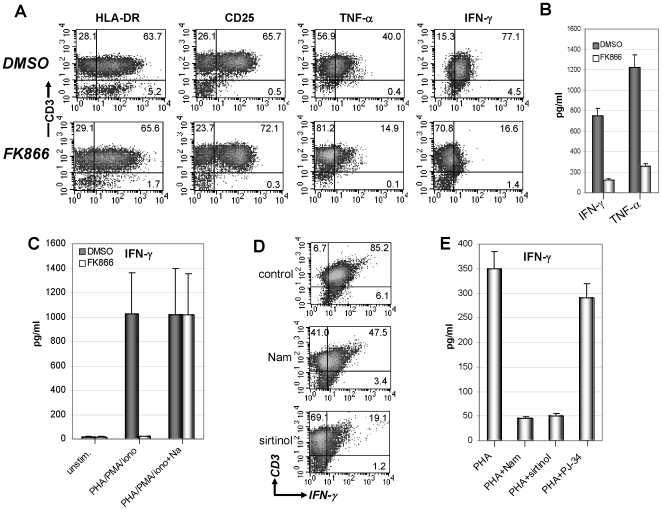
Intracellular NAD+ depletion prevents TNF-α and IFN-γ production by activated T lymphocytes.A, B, 5×106 PBLs were stimulated with 5 µg/ml PHA with or without 33 nM FK866 for 36 h and subsequently incubated with 50 ng/ml PMA and 0.5 µM ionomycin for further 5 h. Thereafter, HLA-DR and CD25 expression were detected by flow cytometry. TNF-α and IFN-γ content was determined by intracellular cytokine staining and flow cytometry (A). Released TNF-α and IFN-γ were measured by ELISA (B). DMSO and FK866-treated cells were 84% and 83% viable, respectively. C, 5×106 PBLs were stimulated with PHA and PMA/ionomycin as above, or left unstimulated. Where indicated, 33 nM FK866 with or without 10 µM Na was added. Released IFN-γ was measured by ELISA. Unstimulated PBLs treated with DMSO or FK866 were 96.3% and 96.5% viable, respectively. PBLs stimulated with PHA/PMA/ionomycin and treated with DMSO or FK866 were 89% and 89.5% viable, respectively. PBLs stimulated with PHA/PMA/ionomycin/Na and treated with DMSO or FK866 were 88% and 87% viable, respectively. D, PBLs were stimulated with PHA and PMA/ionomycin as describe for panel A. Where indicated 10 mM Nam or 50 µM sirtinol were added. Thereafter, cells were harvested and intracellular IFN-γ content was determined by flow cytometry. E, PBLs were stimulated with PHA and PMA/ionomycin as above in the presence or absence of 10 mM Nam, 50 µM sirtinol, or 10 µM PJ34. 42 h later, the supernatants were collected and IFN-γ levels were detected by ELISA. Results are means ± SD of four experiments (B, C, E). Panels A and D are representative of four separate experiments.